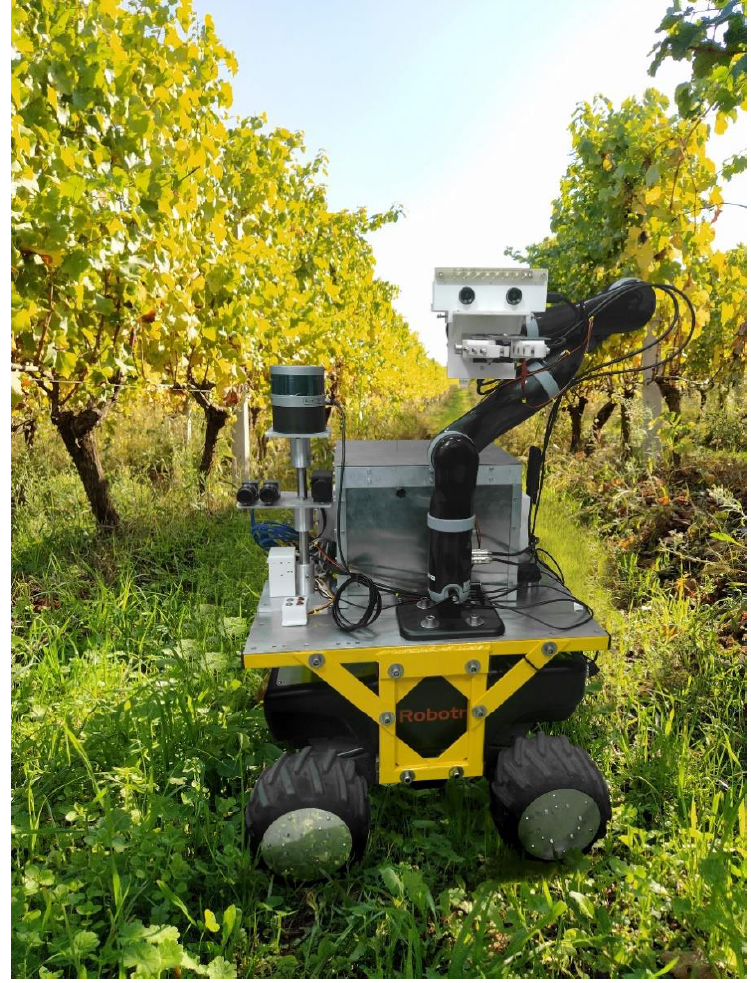
Figure 2. ARG ground unit prototype.